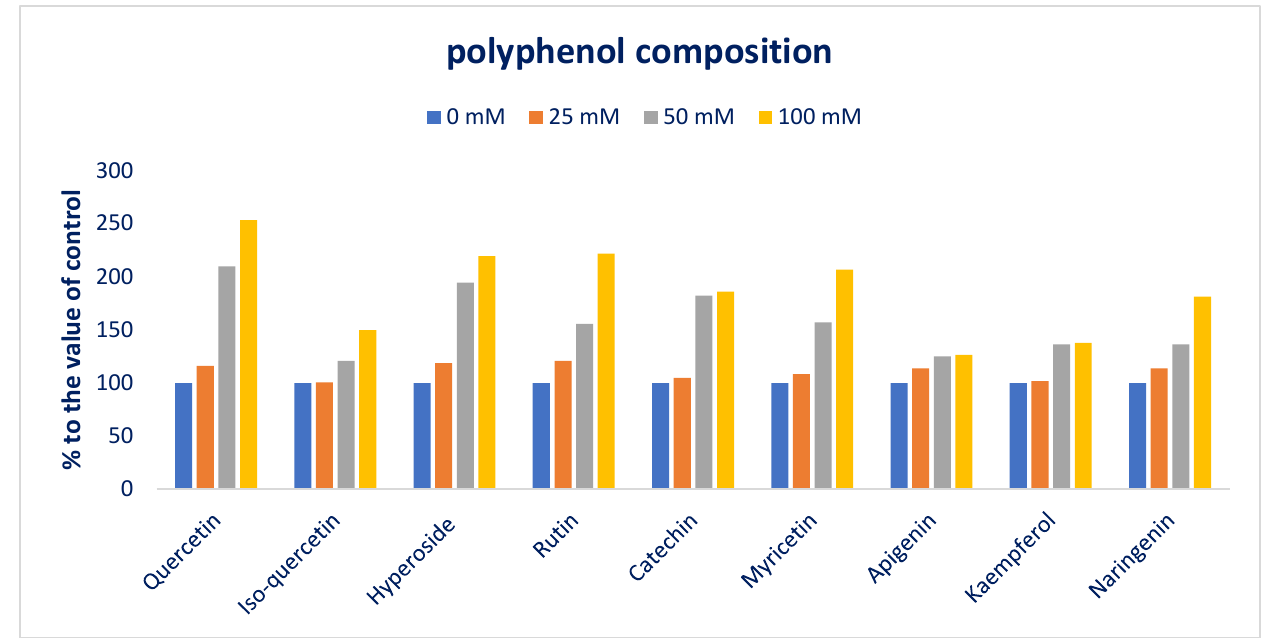
Figure 10. Comparison of the salt-induced increment in polyphenolic compounds (%) over control in Lalshak.